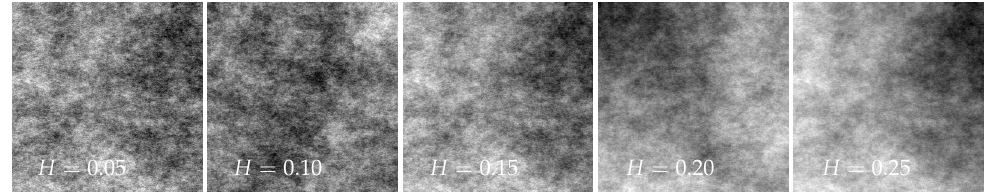
Figure 5. Artificial fractal structures for different Hurst exponents.